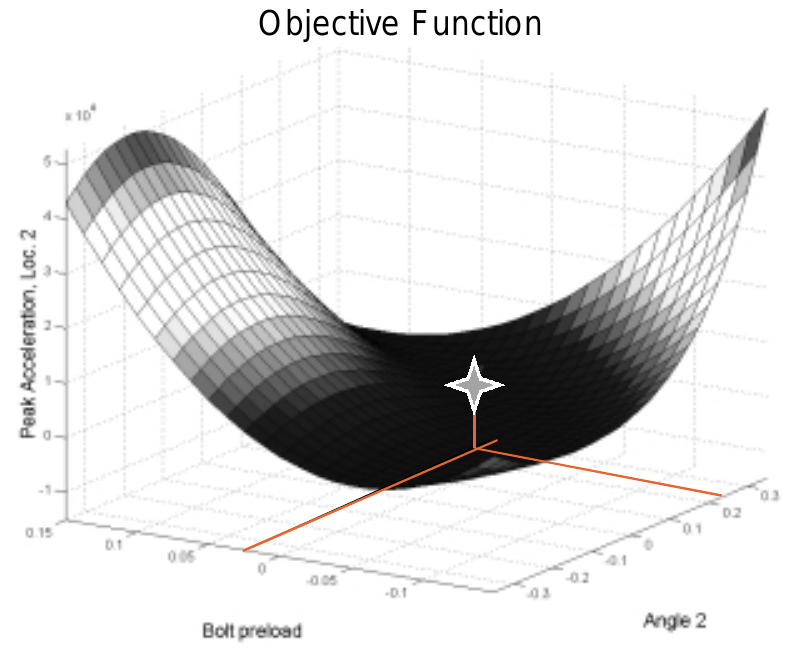
Fig. 12. Surface of objective function for